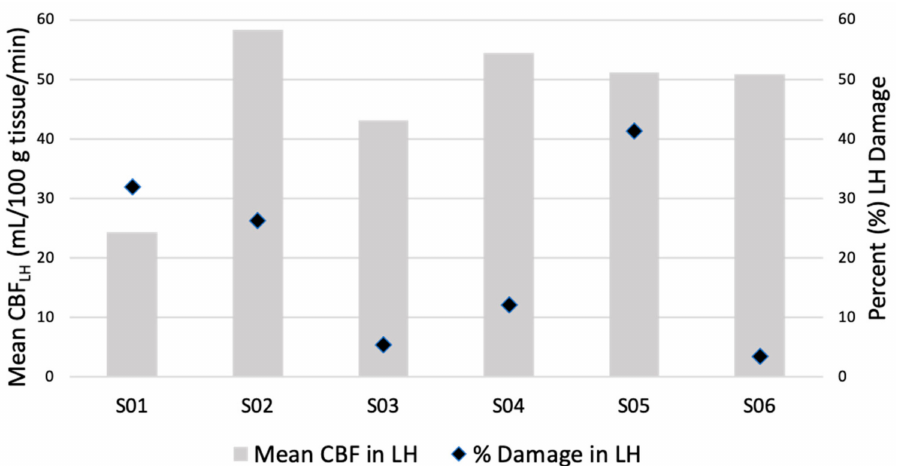
Figure 2. A comparison between mean CBF in remaining intact tissue of the left hemisphere (CBF LH ) and percent lesion damage in the left hemisphere (LH). There is no clear relationship between mean CBF LH and lesion size in our sample which suggests that CBF in remaining intact tissue is not influenced by lesion size